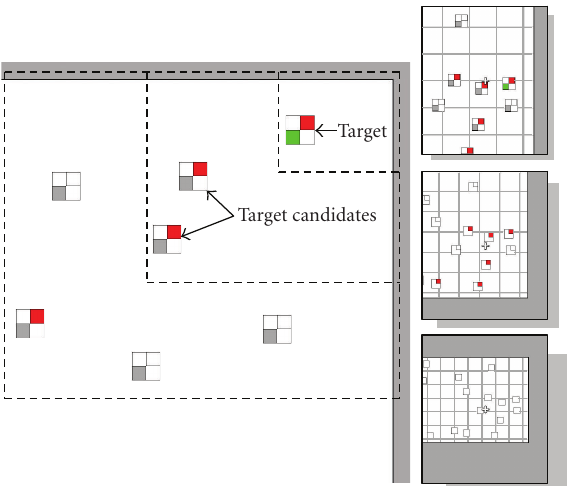
Figure 4: Semantic zooming with three levels of detail. Continuous scaling within each level. The dashed lines indicate the sizes of the respective areas at di ff erent zoom